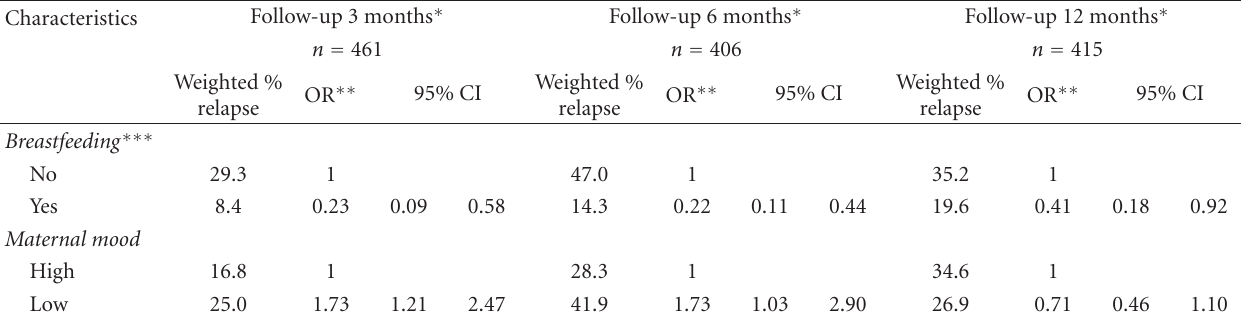
Table 4: Smoking relapse and the association with breastfeeding and maternal mood at each follow-up.